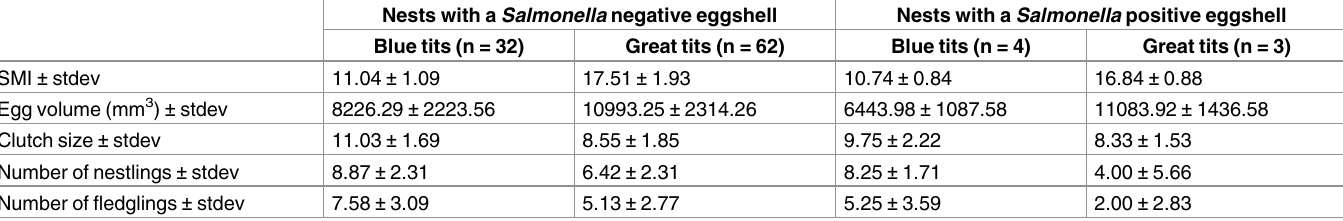
Table 3. Health and reproductive parameters of blue and great tits. Shownare the mean health and reproductive parameters ± stdev, includingSMI, egg volume, clutch size, number of nestlingsand numberof fledglings,of blue and great tits in nests containing an egg with a Salmonella negativeor positive eggshell.